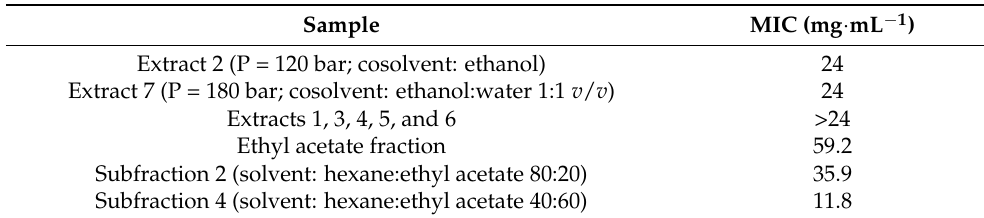
Table 2. Minimal inhibitory concentration (MIC) of A. mearnsii crude extracts and its purified fractions against S. aureus